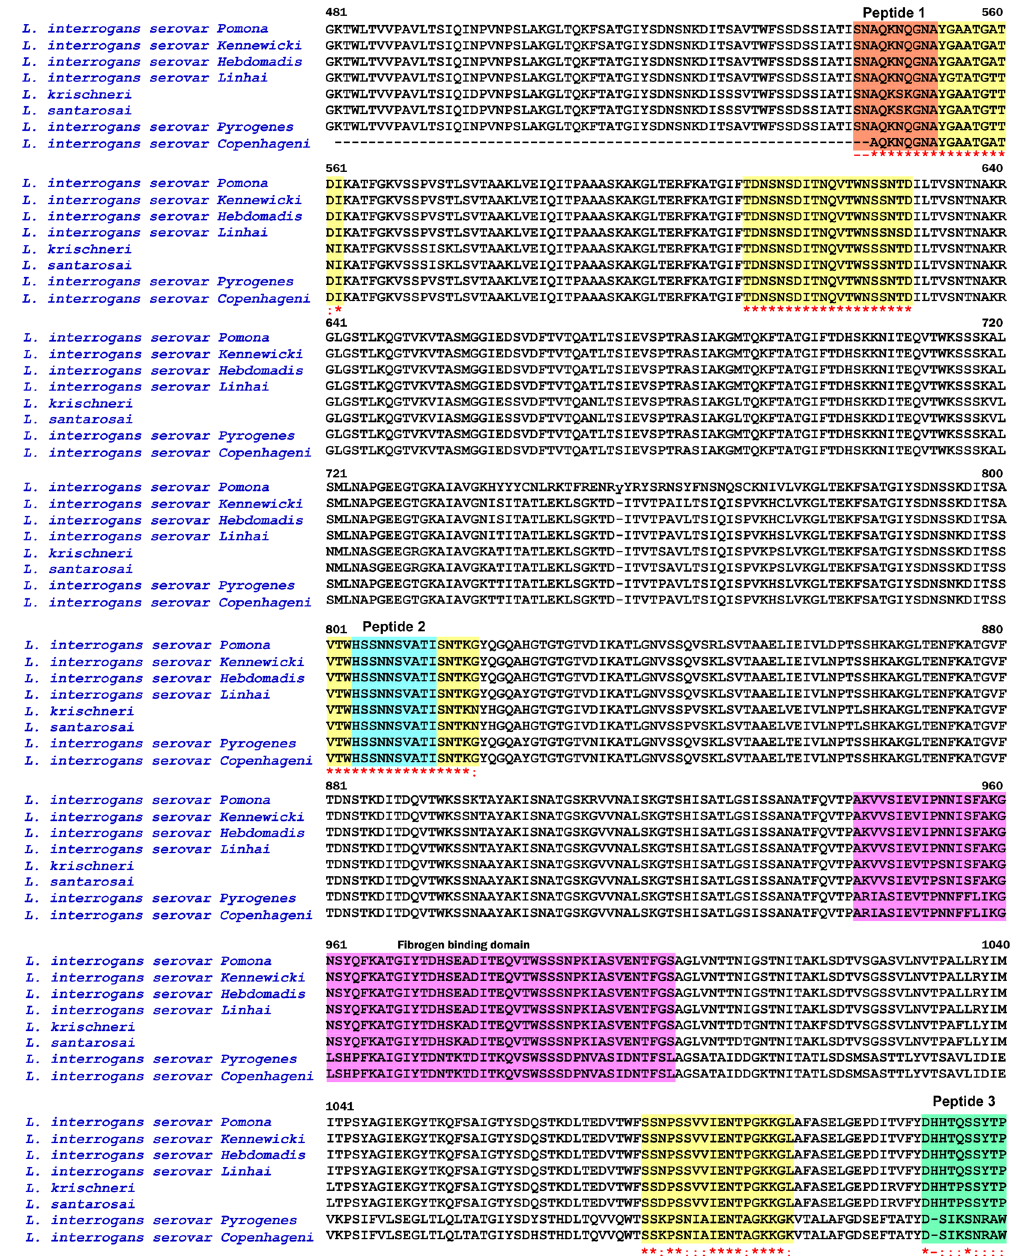
Figure 1. Conservation of the predicted epitopes as determined by multiple sequence alignment among different serovars of Leptospira . The LK90 sequences of L. interrogans serovar Pomona (GenBank accession number AAN52495), L. interrogans serovars Kennewicki (ACH98097), L. interrogans serovar Hebdomadis strain R499 (ERK38429), L. interrogans serovar Linhai strain 56609 (AJR13073), L. kirschneri (WP_020779015), L. santarosai (WP_020766576), L. interrogans serovar Pyrogenes (EMN28036), L. interrogans serovar Copenhageni strain HA10188 (EM018189) were retrieved from GenBank and analyzed with the BioEdit sequence alignment editor (version 7.1.3.0). The predicted B-cell epitopes are